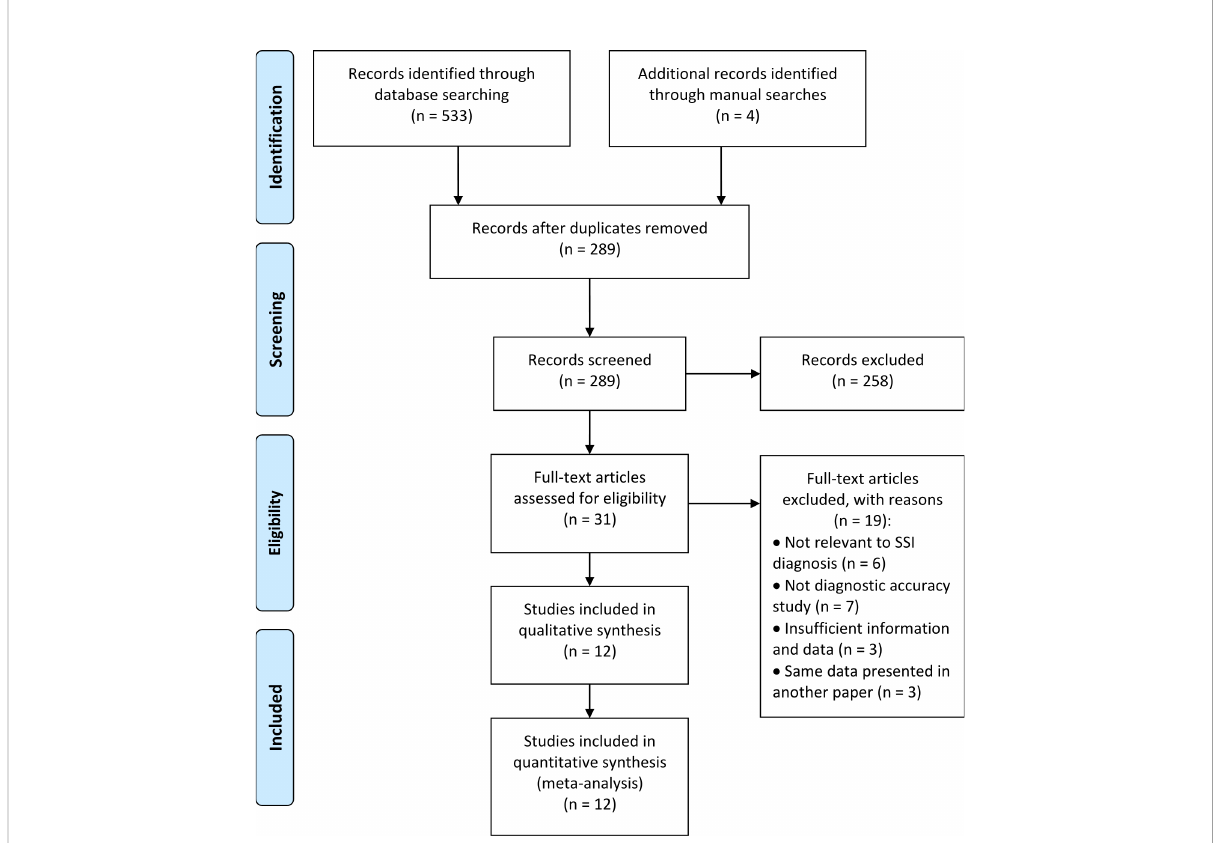
FIGURE 1 Flowchart of study